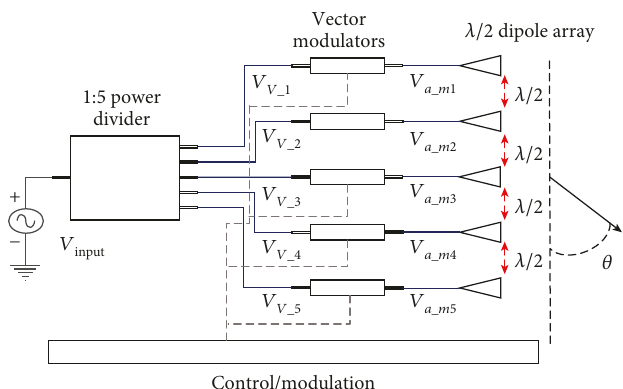
Figure 1: Transmission system demonstrator block diagram.